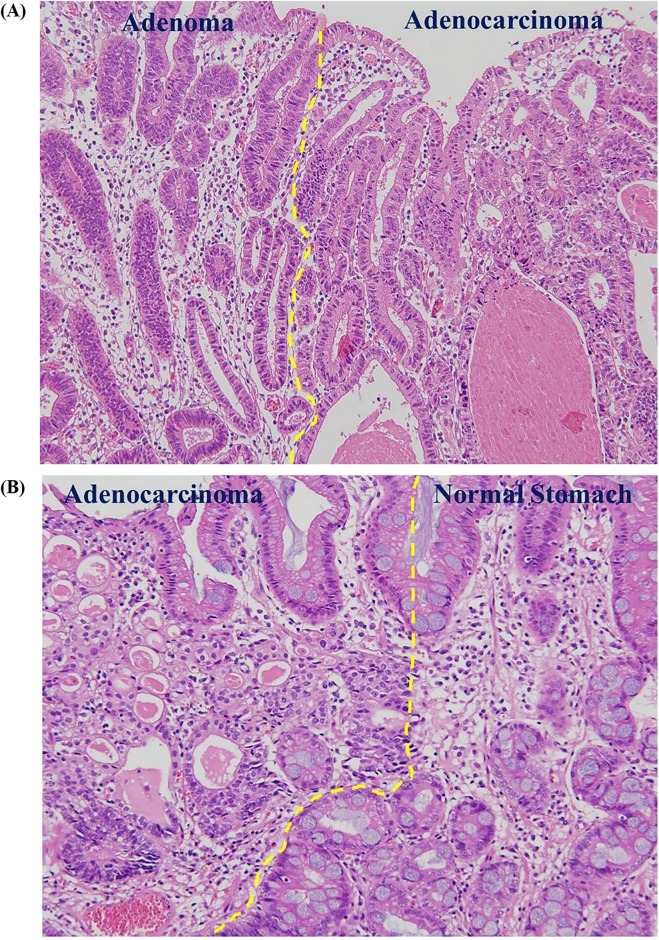
Histopathology of early gastric cancers with or without pre-existing adenoma.(A) Representative image of the ex-adenoma group. Adenomatous components (left) were detected at the margin of the tubular adenocarcinoma (right) (Hematoxylin and eosin stain; original magnification, 200×). (B) Representative image of the de novo group. A sharp transition from the normal gastric mucosa (right) to tubular adenocarcinoma (left) was observed. No evidence of gastric adenoma was found in its vicinity.